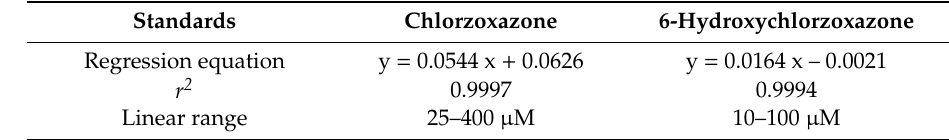
Table 1. Analytical performance.